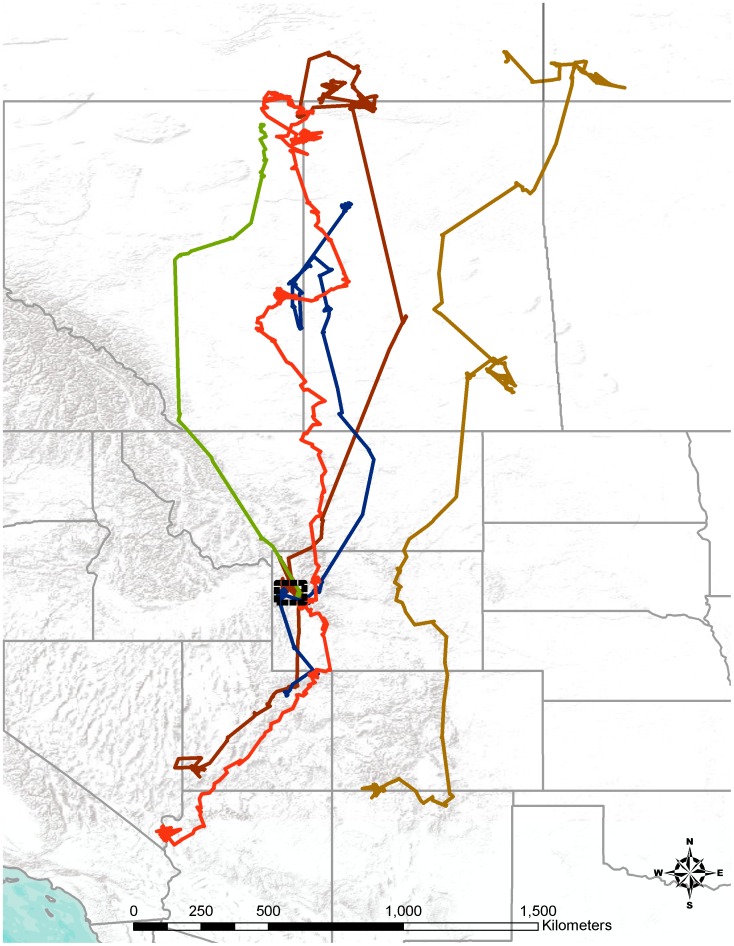
Bald eagle fall migration routes.Fall migratory (August 2010– January 2011) routes of bald eagles captured the previous fall (2009) in Jackson Hole, Wyoming. Four of the five eagles returned to Jackson Hole during the big game hunting season a year after being tagged.